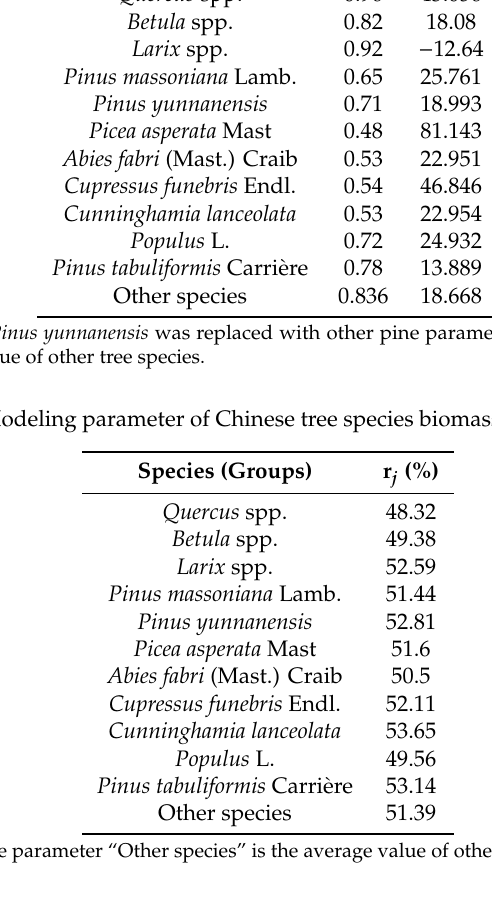
Table A4. Fitting results for the Richards (1959) equation for di ff erent species. Species